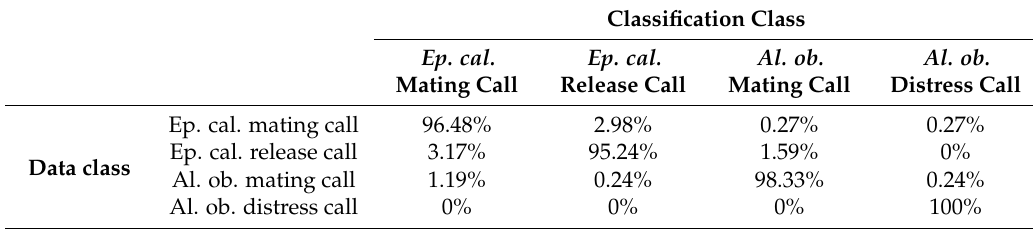
Table 8. Performance metrics for three pairs of (score, frame) classifiers.